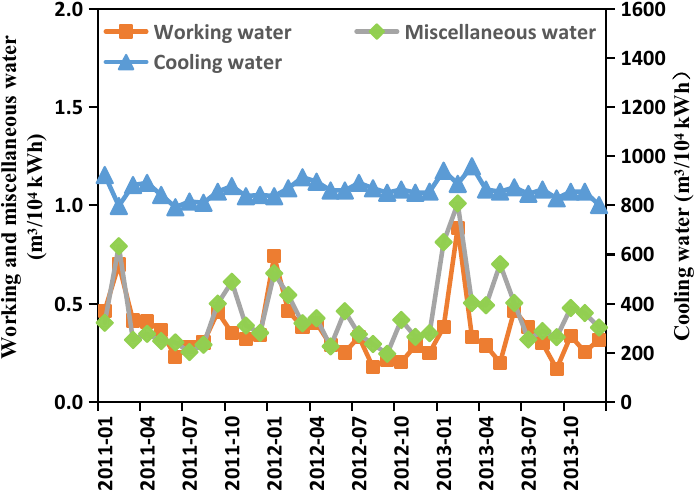
Figure 8. Water consumption for electricity generation at the Shenzhen Eastern gas-fired power plant from January 2011 to December 2013..